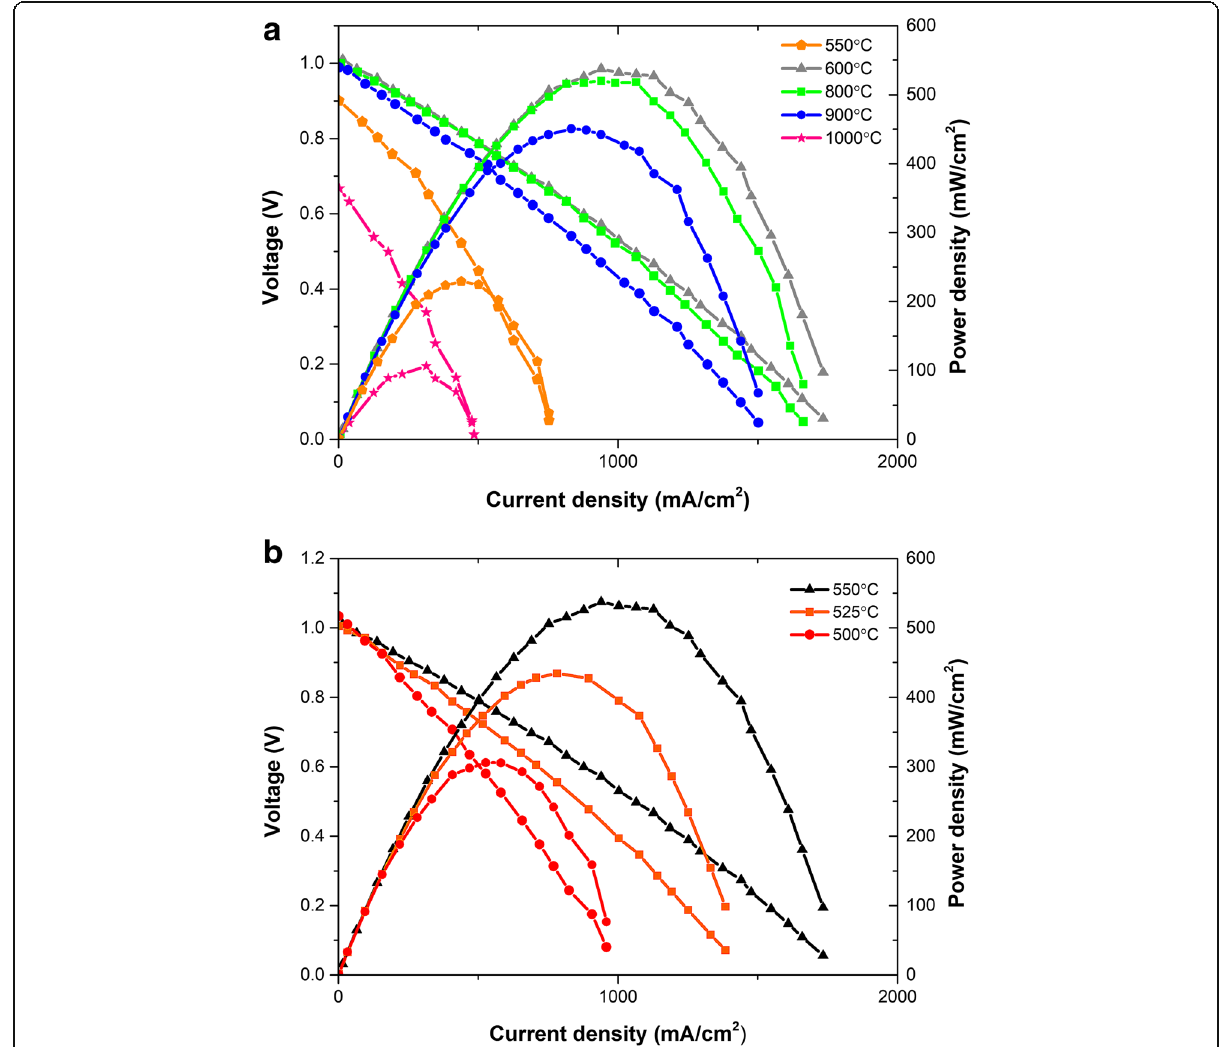
Fig. 4 Voltage-current density and power density-current density characteristics for the a fuel cells assembled from LSCF-SCDC pellets sintering at various sintered temperatures. b The electrochemical performance of 600 °C sintered cell operating at 500 – 550